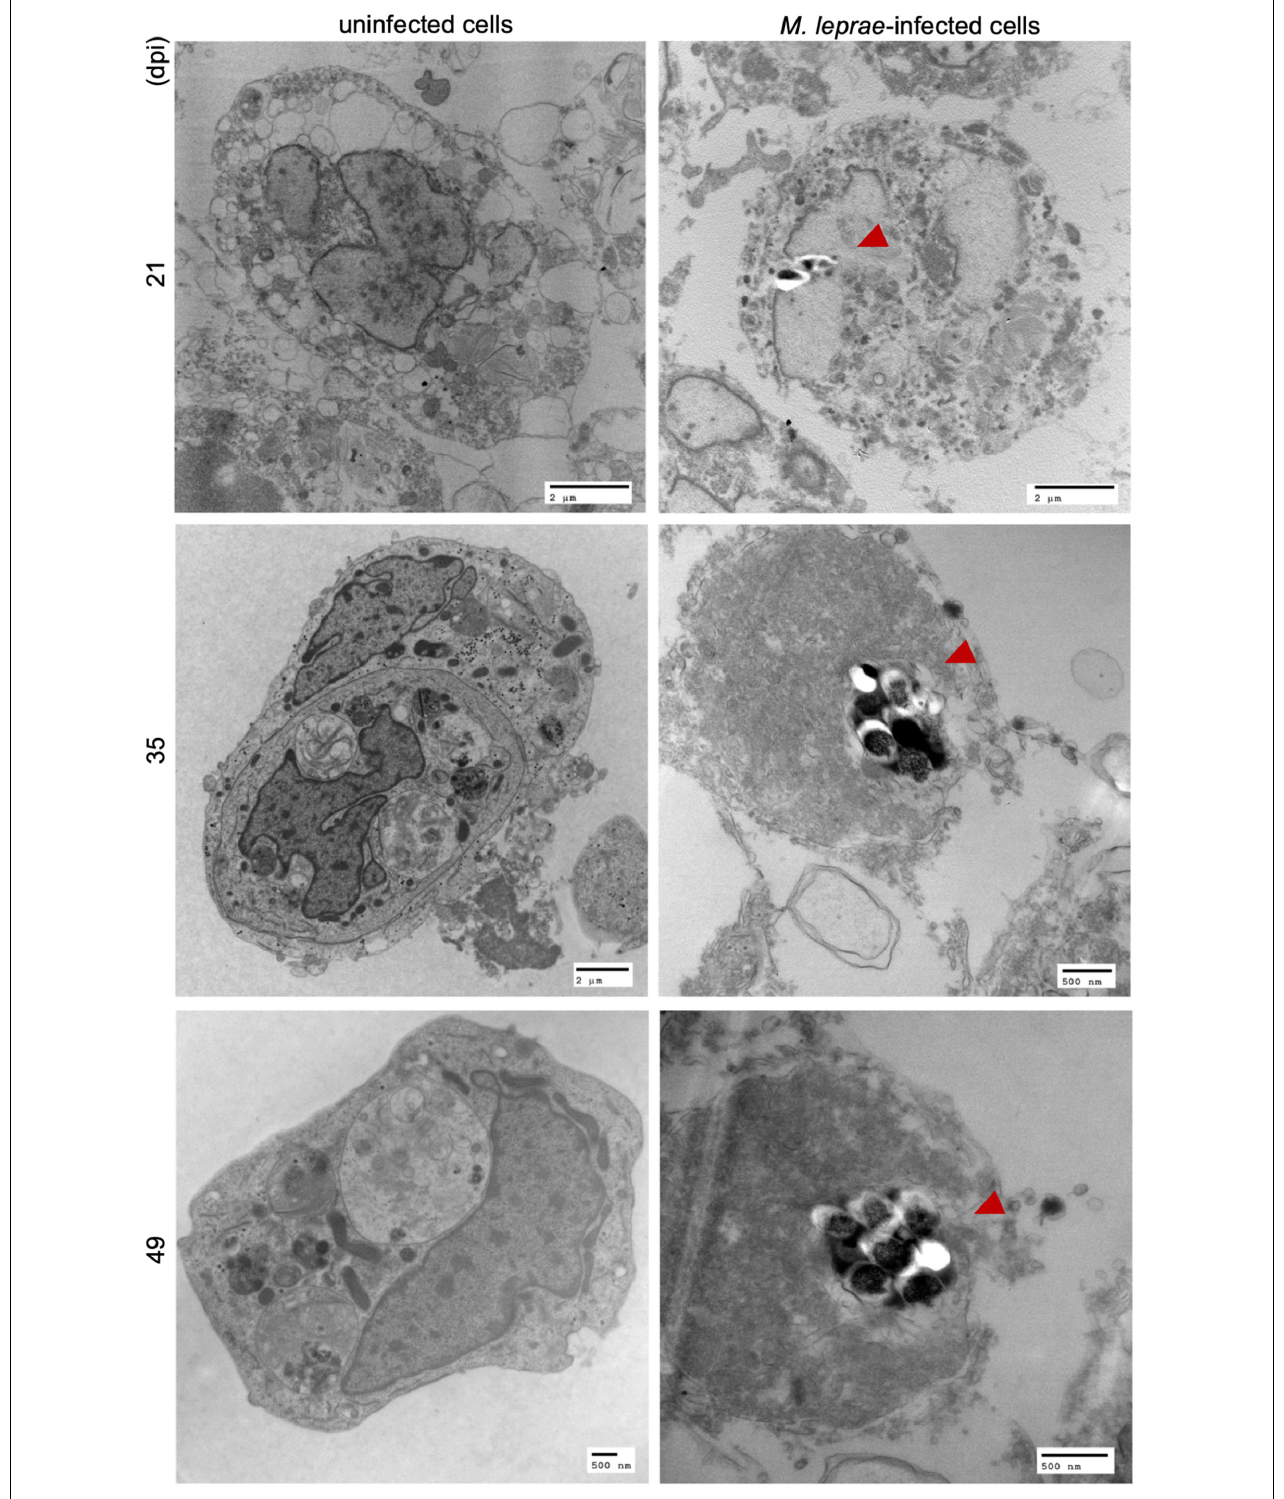
FIGURE 3 | TEM imaging on M. leprae Thai-53 strain infected in tick-derived cell lines. ISE6 cells on coverslips were infected with M. leprae Thai-53 strain. Infected and uninfected samples at 21, 35, and 49 dpi were prepared for TEM imaging. Images were captured using TEM microscope and bacilli were indicated by red